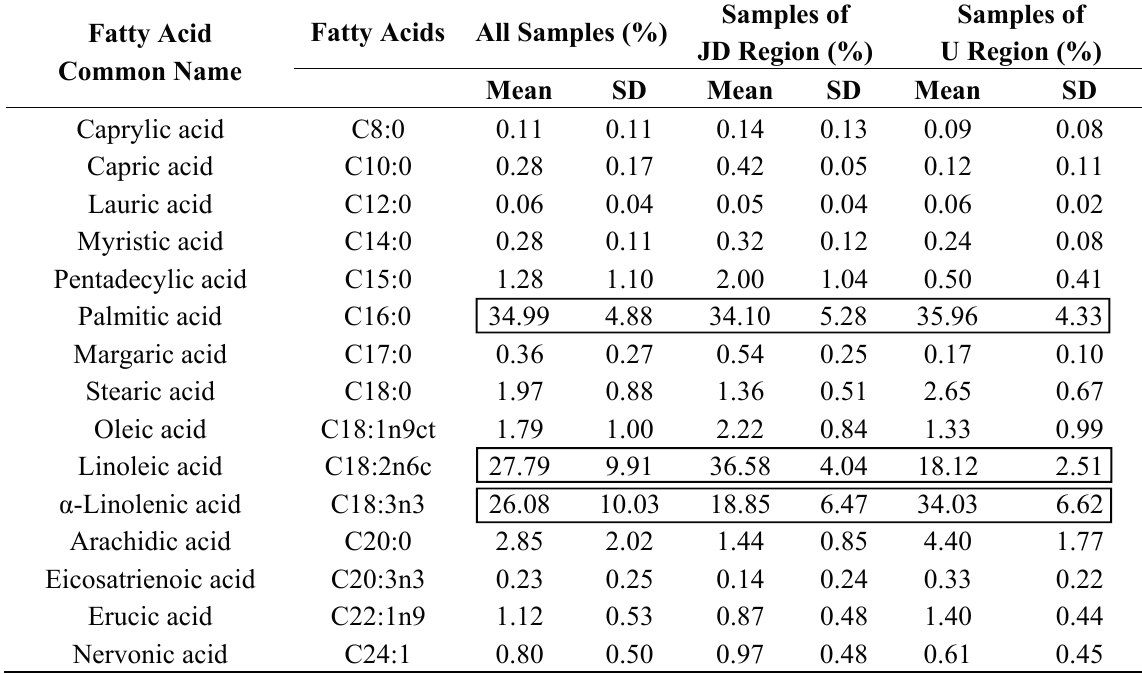
Table 2. Descriptive analysis of pollen’s fatty